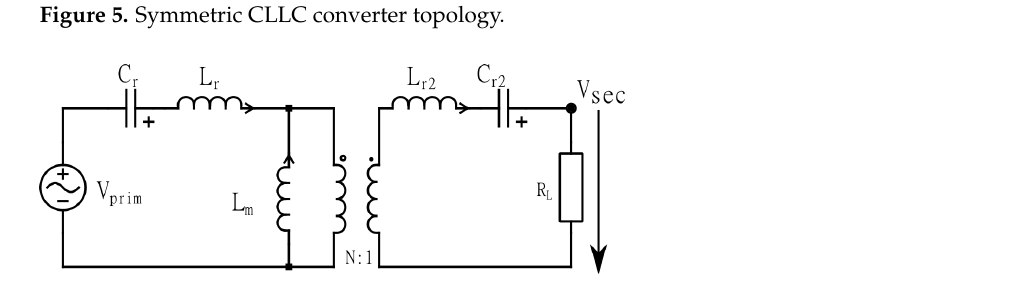
Figure 6. FHA model of the symmetric CLLC.